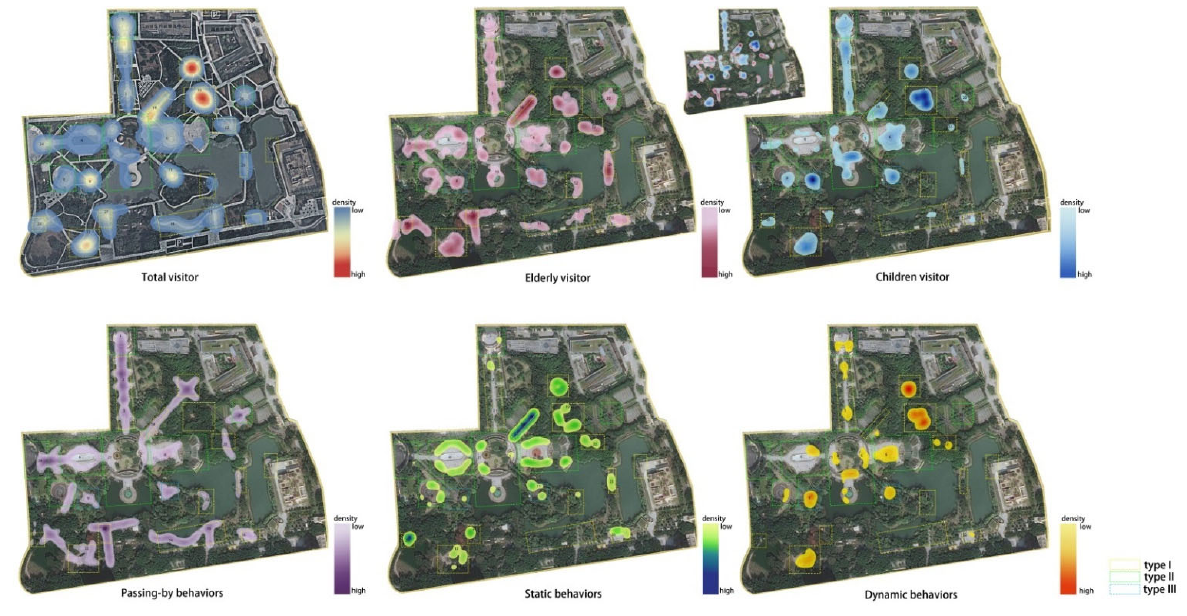
Figure 8. Spatial distribution of each behavioral feature.